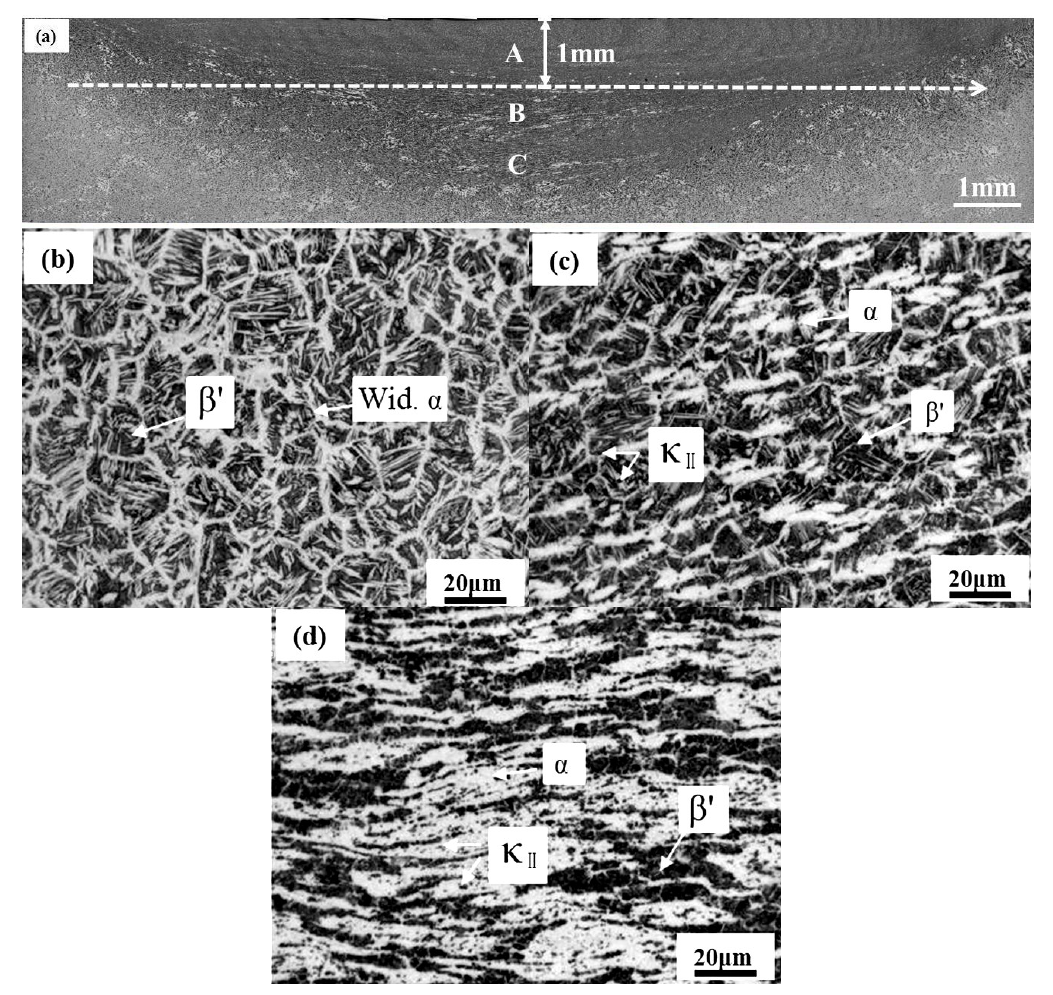
Figure 2. OM images showing the microstructure of FSP NAB alloy. ( a ) Profile. ( b ) Region A in Figure 2a. ( c ) Region B in Figure 2a. ( d ) Region C in Figure